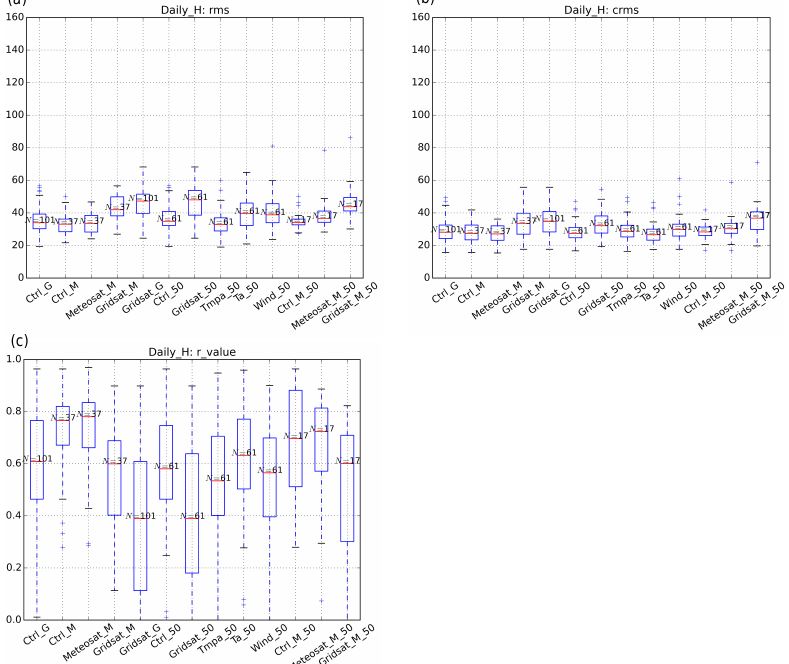
Figure D5. Similar error statistics for sensible heat flux like in Fig. 10 but for daily values: (a) RMSD, (b) cRMSD, (c) correlation coefficient.